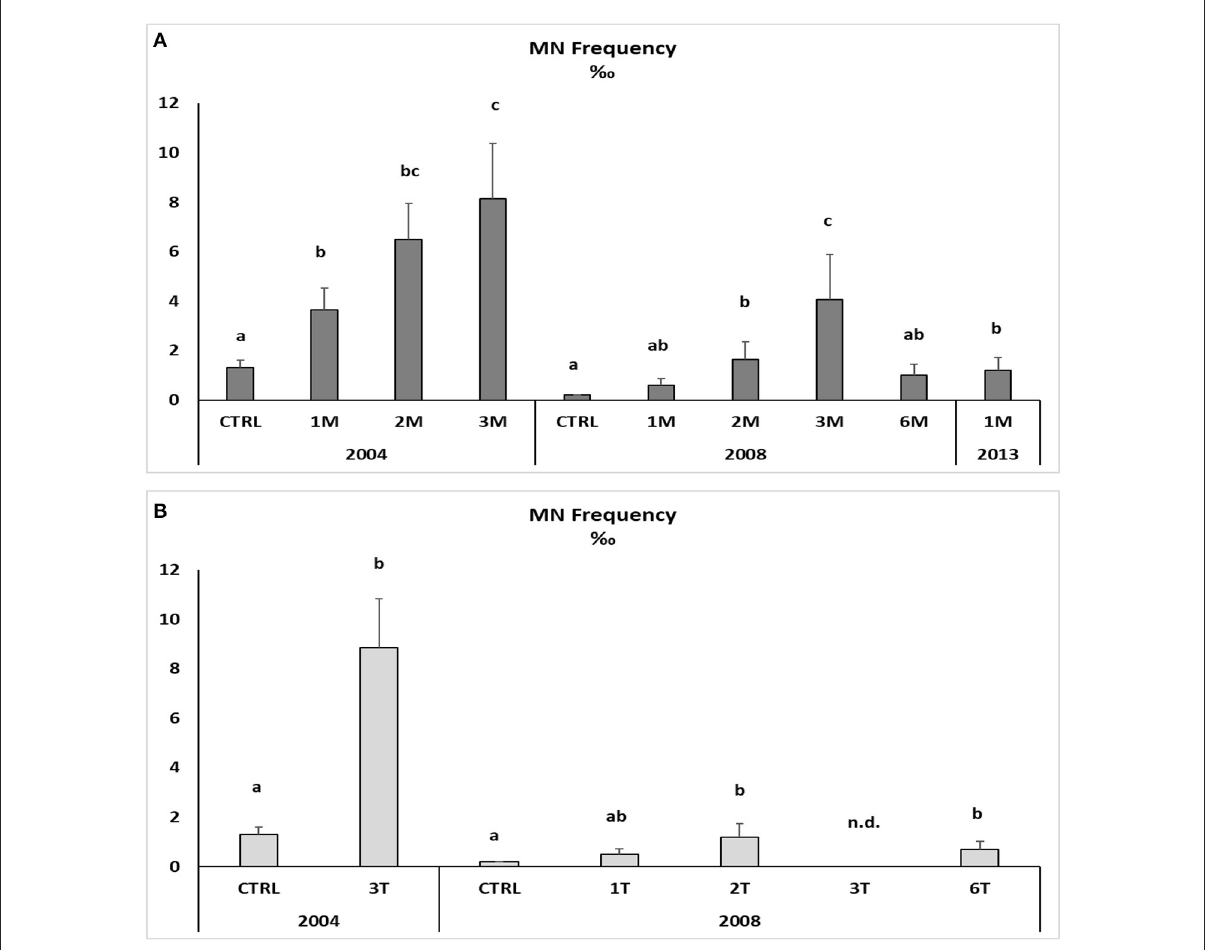
FIGURE3 Micronuclei frequency in the haemolymph of native (A) and transplanted (B) mussels. Data are expressed as mean ± SEM and n = 5. Letters indicate differences among all the sampling sites for each year p < 0.01; n.d., not